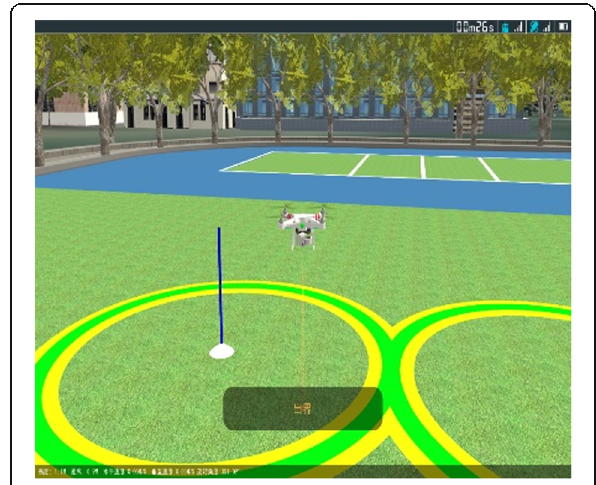
Fig. 10 Unmanned aerial vehicle flying around the